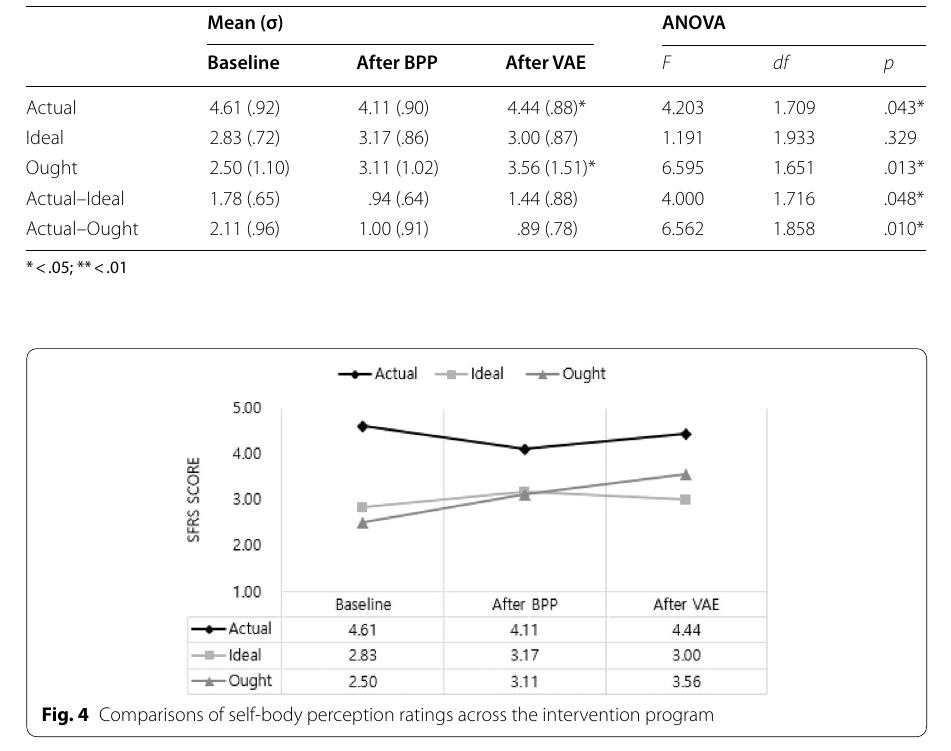
Table 2 Self-body perception ratings across the intervention program